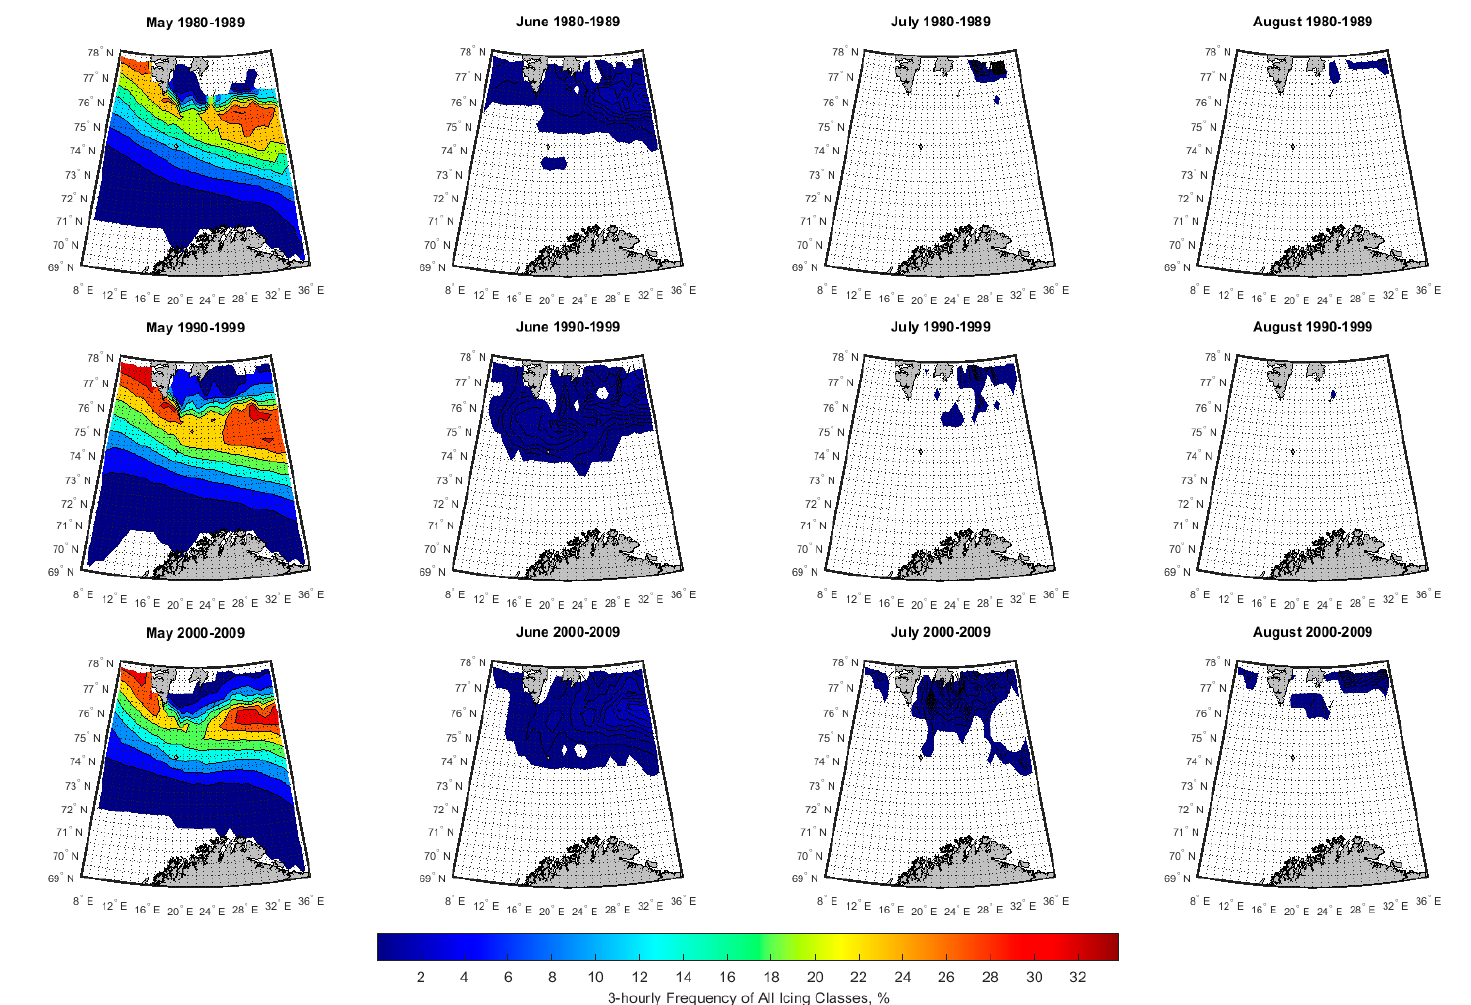
Figure 14. Three-hourly frequency of icing events (all classes) in each region during the 1980s, 1990s, and 2000s (May, Jun, Jul, Aug).